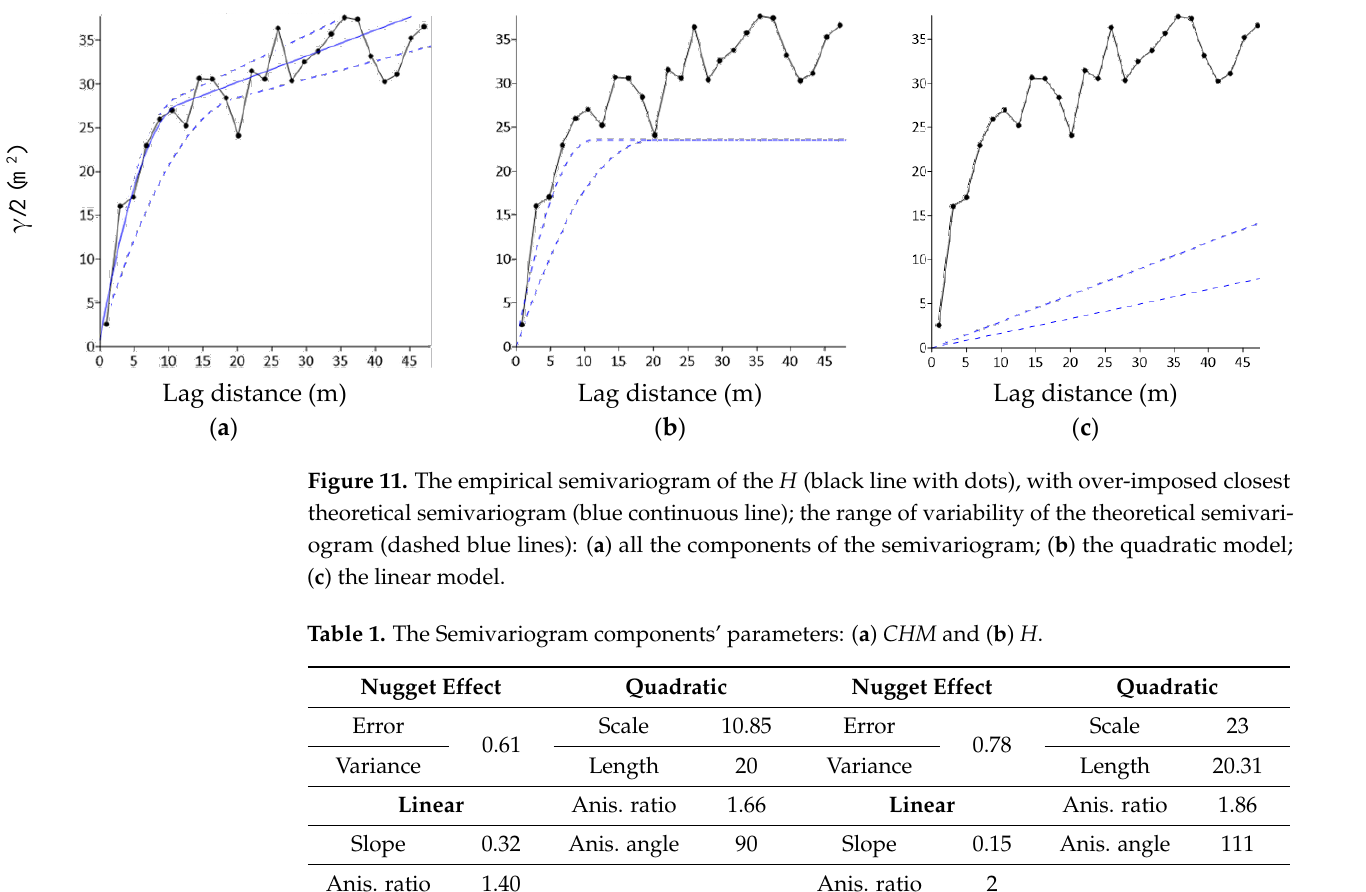
Figure 10. The empirical semivariogram of the CHM (black line with dots), with over-imposed clos- est theoretical semivariogram (blue continuous line); the range of variability of the theoretical sem- ivariogram (dashed blue lines): ( a ) all the components of the semivariogram; ( b ) the quadratic model; ( c ) the linear model.